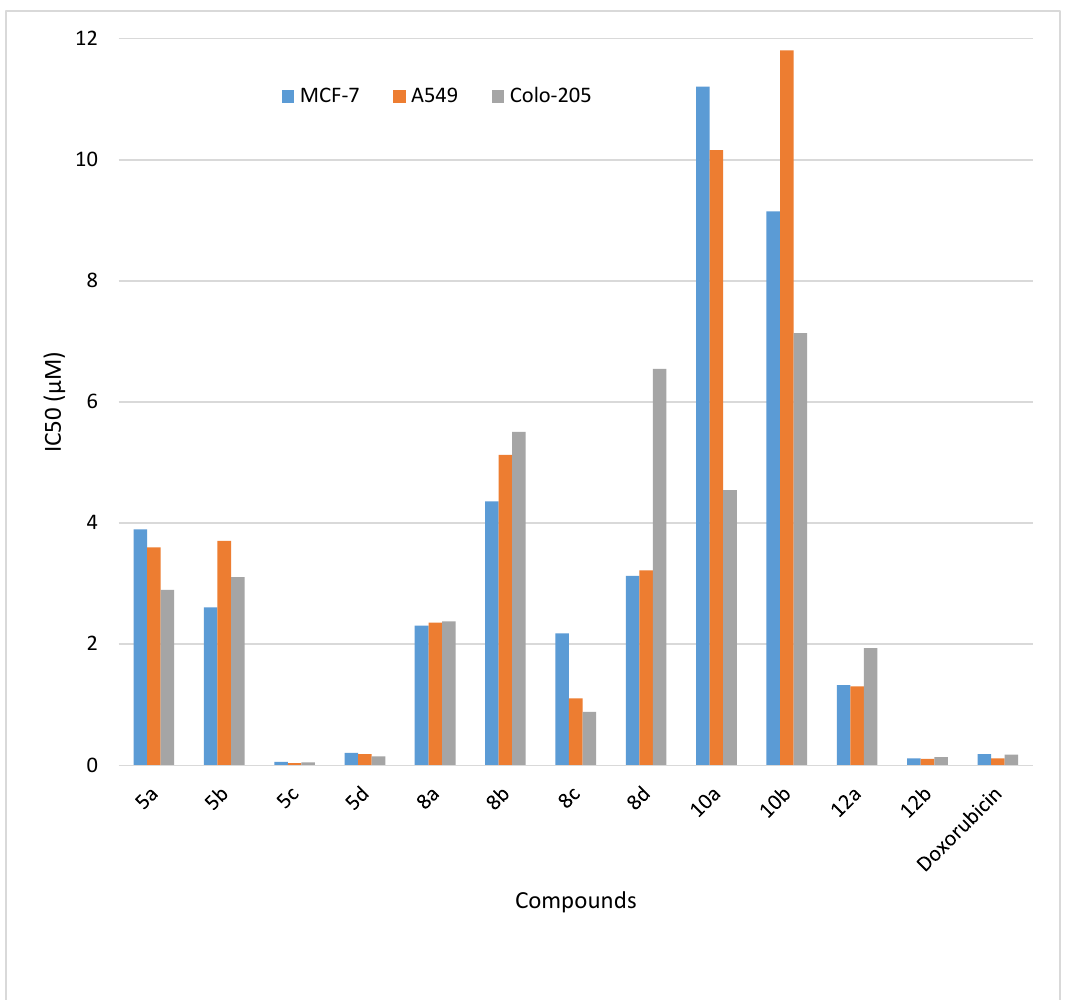
Figure 3. The in vitro activity of the newly synthesized derivatives against MCF-7, A549, and Colo-205 human cancer cell lines.